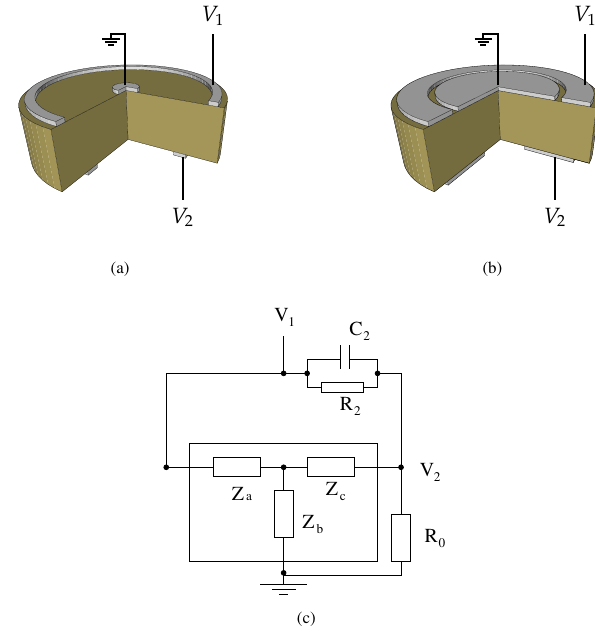
Figure 2. (a) Arrangement of electrodes in thin rings; (b) arrange- ment of electrodes in wide rings; (c) schematic diagram of the whole circuit with the piezoceramic shown as a